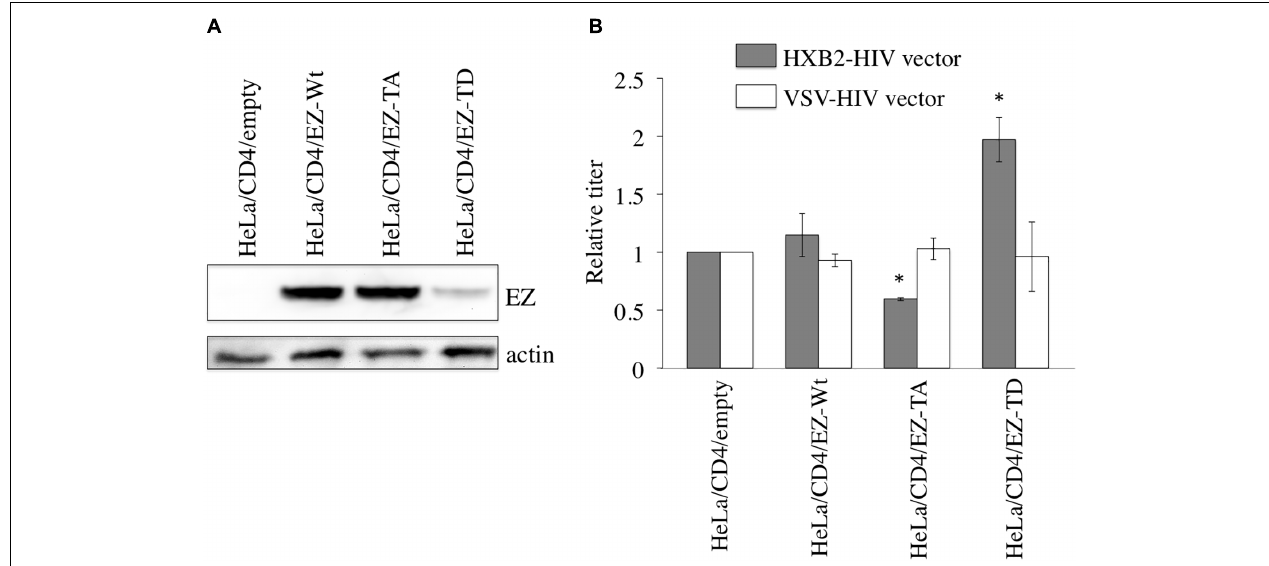
FIGURE 1 | Ezrin phosphorylation in target cells is required for efficient X4-tropic HIV-1 infection. (A) Expression levels of C-terminally VSV-G epitope-tagged EZ-Wt, EZ-TA, and EZ-TD proteins in HeLa/CD4 cells were analyzed by western immunoblotting using the anti-VSV-G epitope antibody (upper panel). Actin protein served as a control (lower panel). (B) Transduction titers of the X4-tropic Env- and VSV-G-pseudotyped HIV-1 vectors were measured for the empty vector-, EZ-Wt-, EZ-TA-, and EZ-TD-expressing HeLa/CD4 cells. Transduction titers of the empty vector-expressing cells were always set to 1, and relative values of transduction titers in other cells are indicated. Error bars show standard deviations, and asterisks indicate statistically significant differences compared to the empty vector-expression cells.